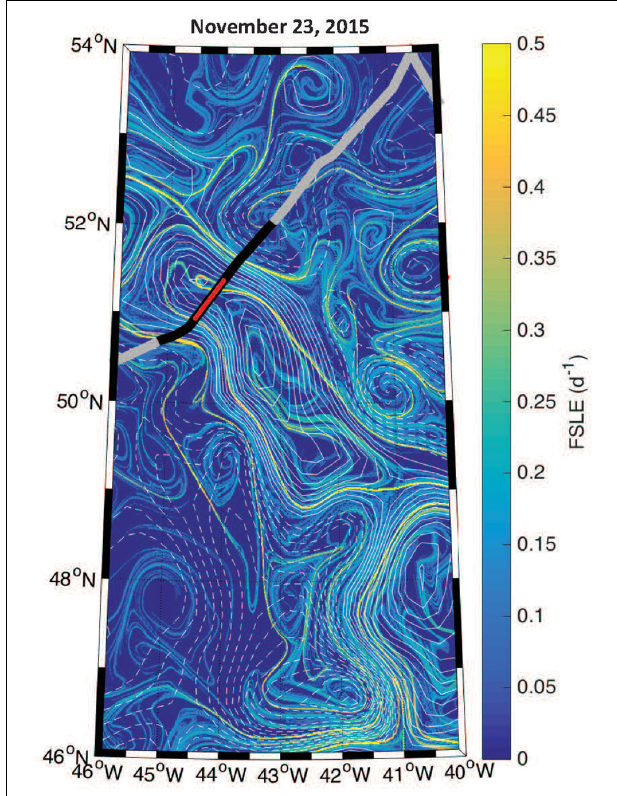
FIGURE 8 | Geostrophic fronts derived from the Finite Size Lyapunov Exponents (FSLE) overlaid with contours of SLA (solid and dashed contours of positive and negative SLA, respectively, at an interval of 3 cm). The thick black line corresponds to the segment of the flight track shown in Figure 6 and the red line shows the eddy